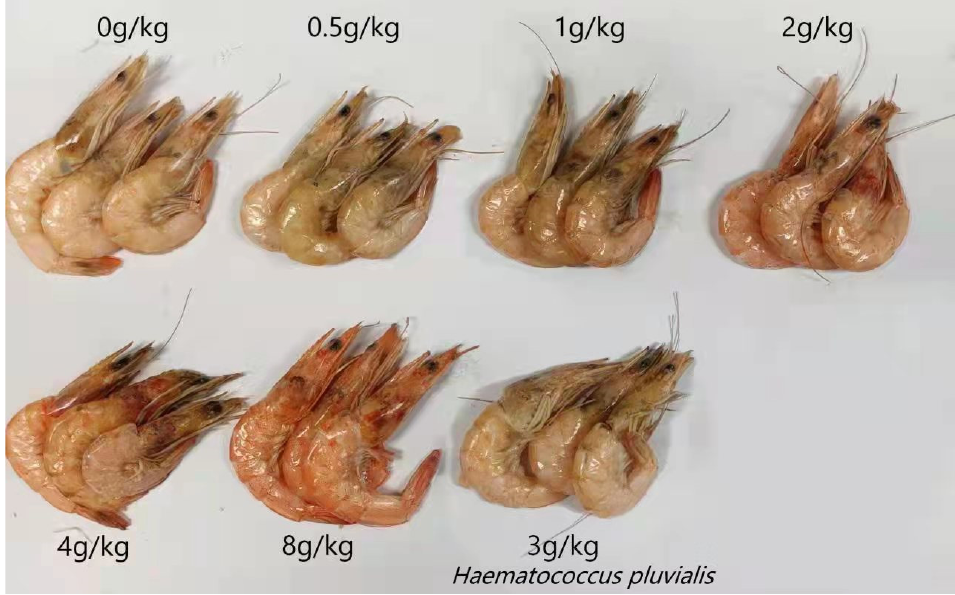
Figure 4. Comparison of body color of boiled Litopenaeus vannamei after 8-week growth trial.